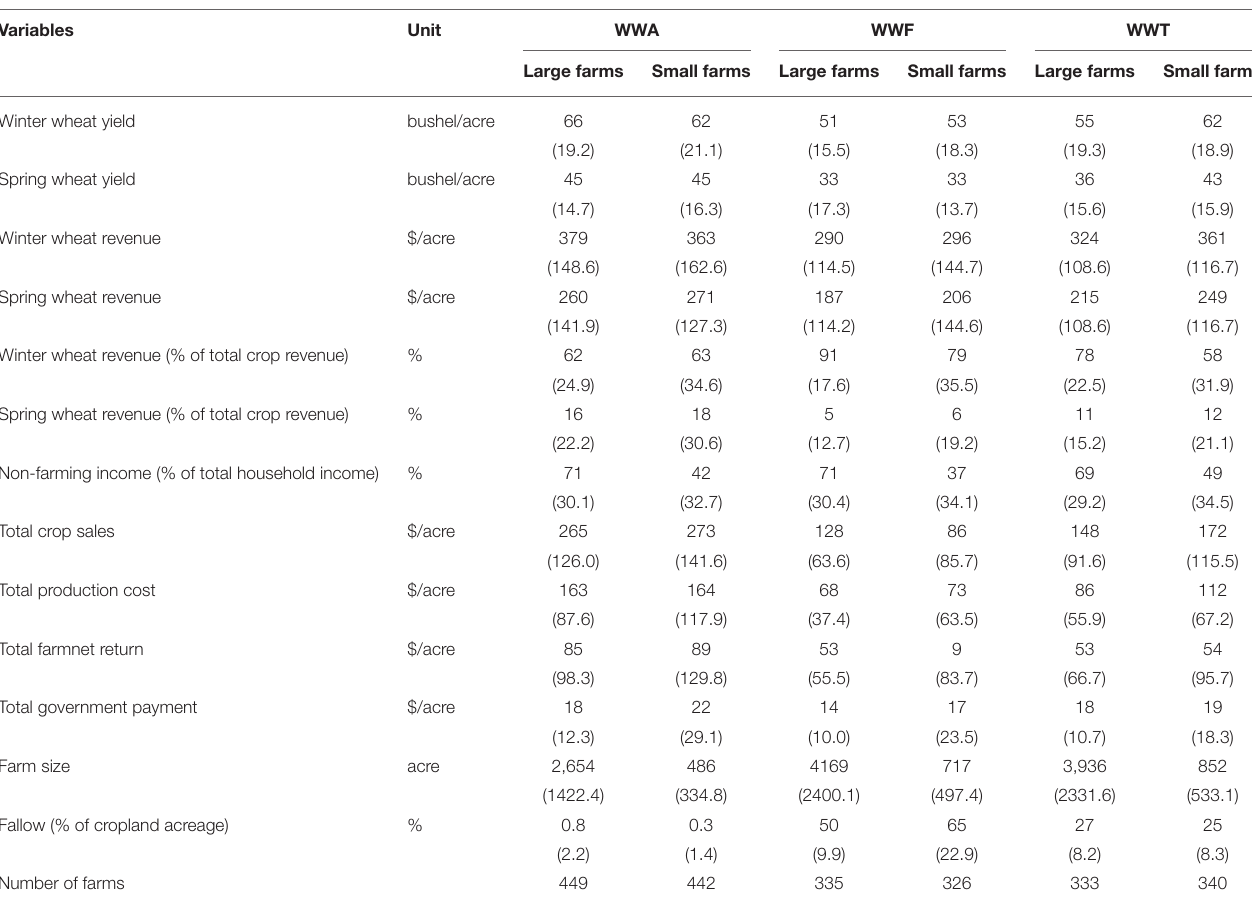
TABLE 4 | Summary statistics from 2007